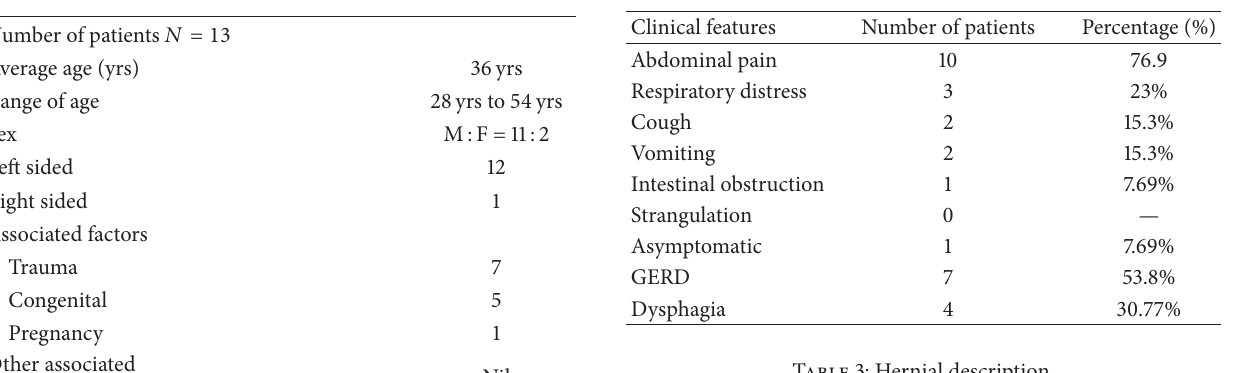
Table 3: Hernial